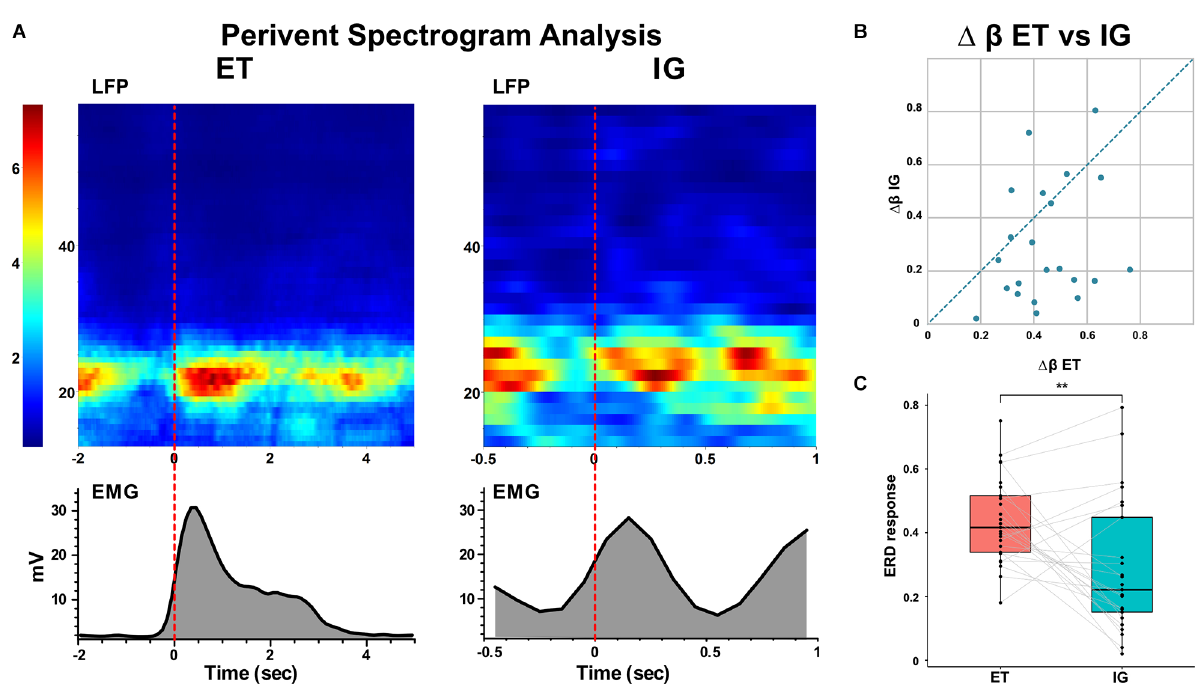
FIGURE2 Event-related beta desynchronization before and synchronization during voluntary ET and IG movements in PD. (A) Examples of perievent spectrogram of LFPs and rectified EMGs during ET and IG movements. X-axis: time, sec; y-axis for LFP: frequency, Hz; y-axis for EMG: amplitude, mV; color scale shows spectrum power, %. (B) Scatter plot of beta ERD during ET (x-axis) and IG (y-axis) movements. Each point marks data from one bipolar. (C) Boxplots with lines of beta ERD to ET and IG movements. LFPs, local field potentials. ** p <